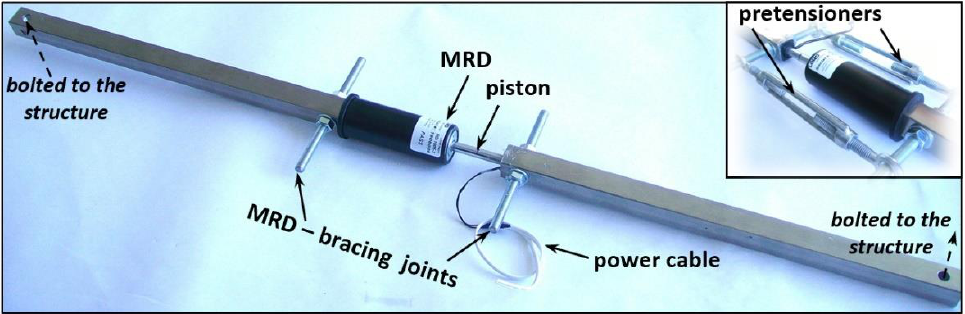
Figure 42. Dissipative bracing that integrates the MRD.